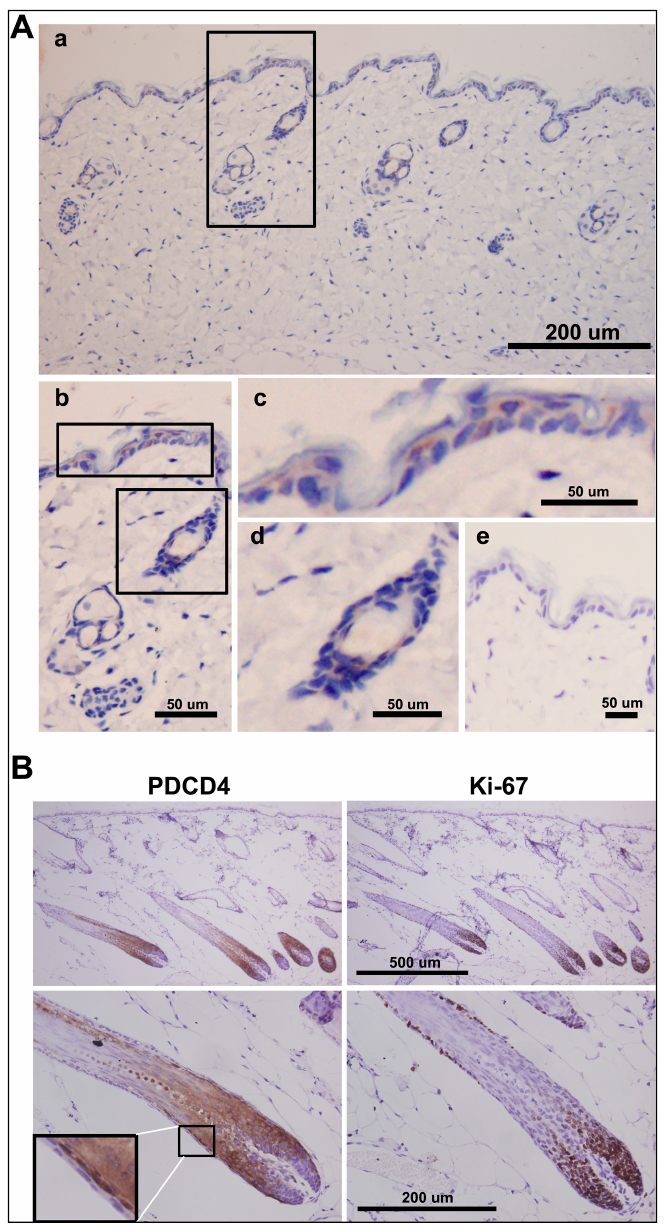
Figure 6. PDCD4 expression and its potential role in epidermis. ( A ) PDCD4 expression in normal mouse skin analyzed by immunohistochemistry. PDCD4 presented diffuse cytoplasmic staining in epidermal cells of interfollicular epidermis, telogen hair follicle and sweat gland ( a ); Partial enlarged detail ( b ); PDCD4 was stained discontinuously in both the suprabasal cells and basal cells of the interfollicular epidermis ( c ); PDCD4 was stained heterogeneously in the telogen hair follicle ( d ); A negative control was presented ( e ); the black box in ( a ) shows the source of the partial enlarged area of ( b ); the black boxes of ( b ) show the sources of partial enlarged drawings of ( c , d ); ( B ) Enhanced expression of PDCD4 in the anagen hair follicle. Top , there is mutual inverse expression of PDCD4 ( left ); and Ki-67 ( right ) in the anagen hair follicle (anagen VI, day 12 after hair growth induction by depilation) as shown at low magnification (×100); Bottom , immunohistochemical localization of enhanced PDCD4 expression in the anagen hair follicle (high magnification, ×400, left ); Localization of Ki-67 in the anagen hair follicle detected by serial section (×400, right ).